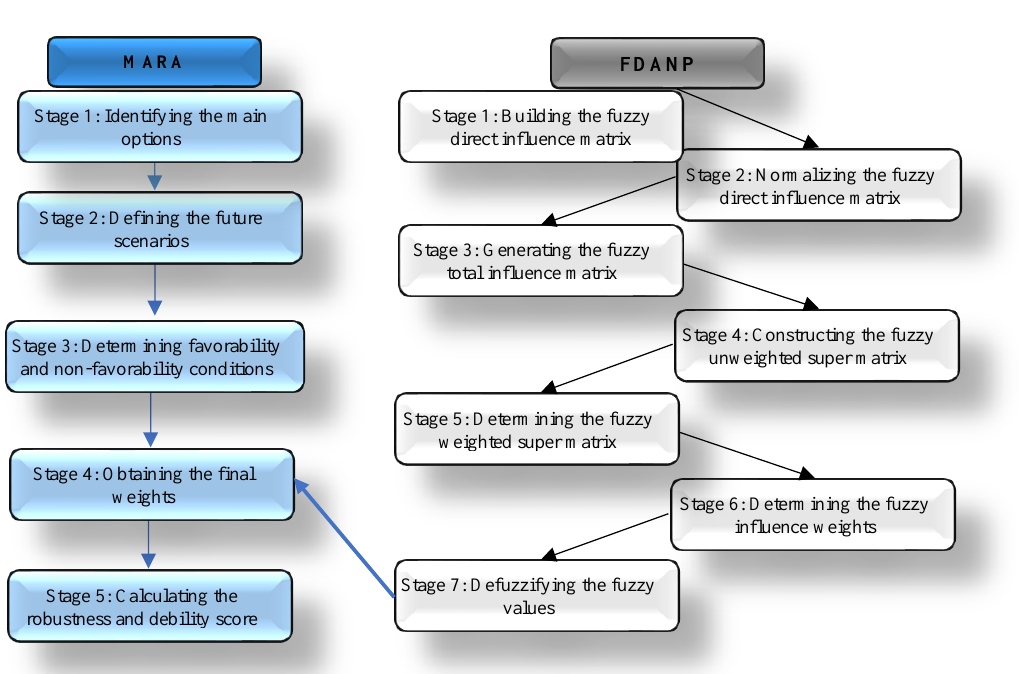
Figure 1. The proposed model